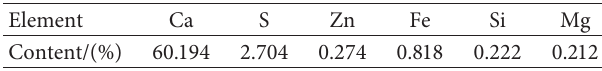
Table 1: Mineral elements in the limestone according to